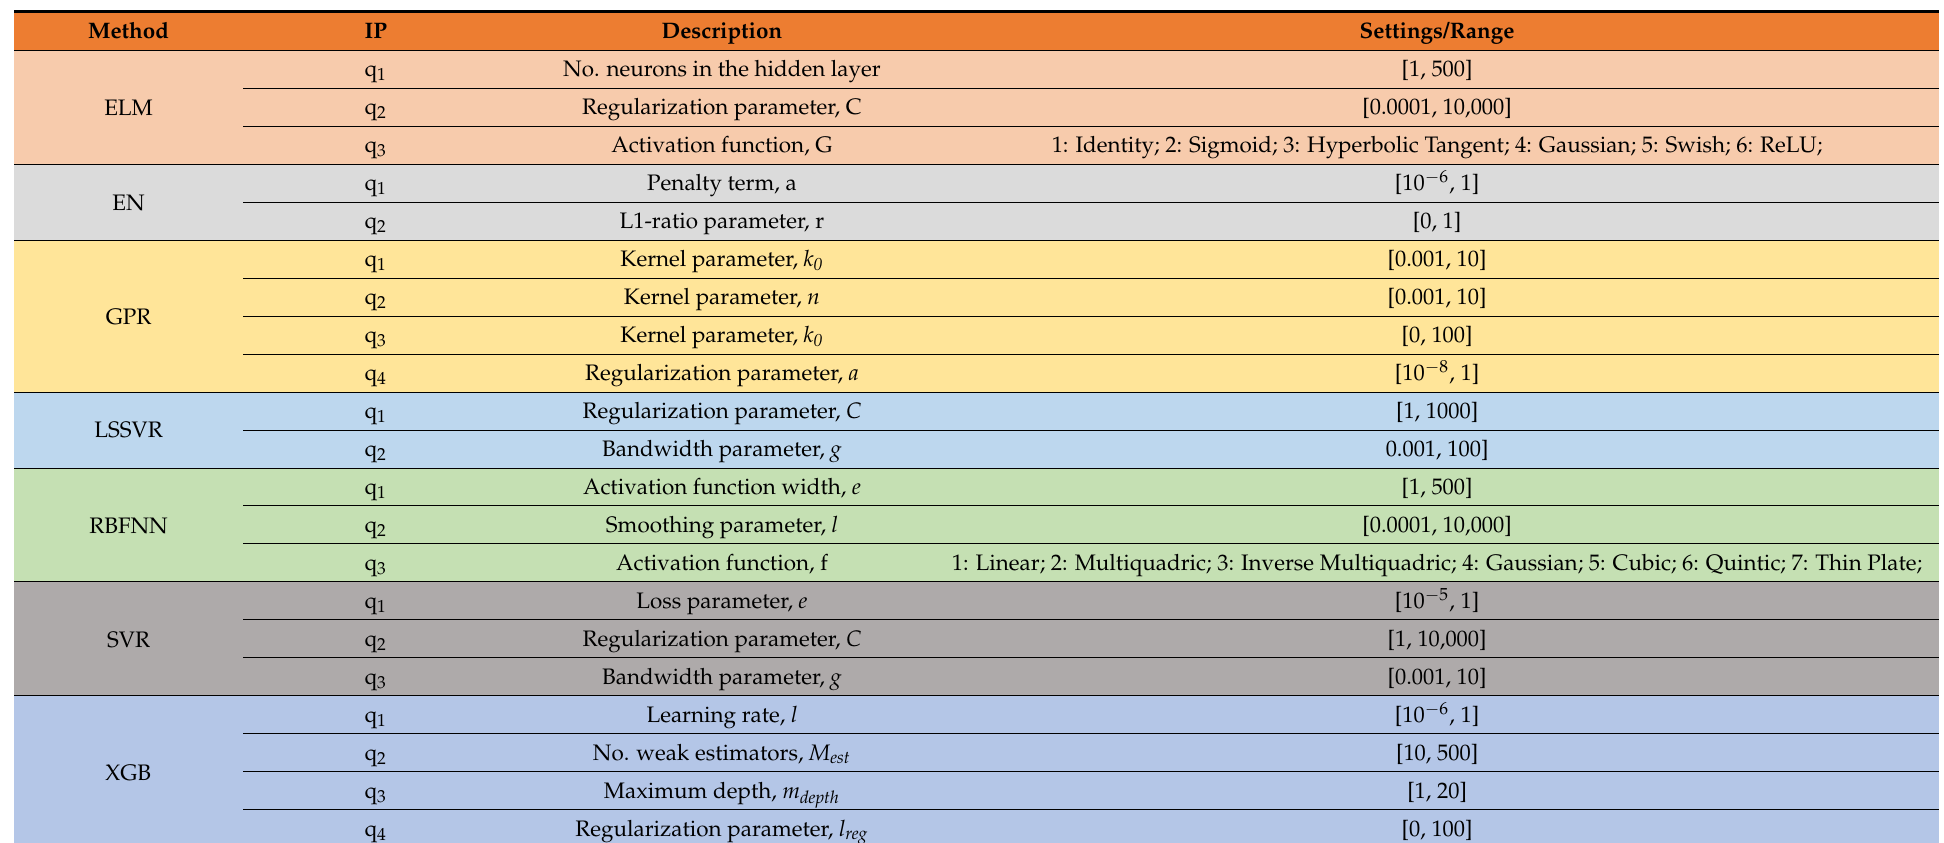
Table 5. Encoding of candidate solutions. The column IP indicates the internal parameter in the CMAES